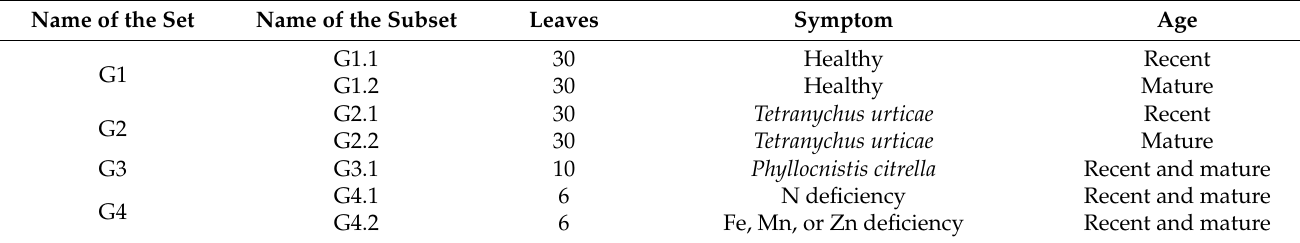
Table 1. Classification of the sets and subsets of the leaves for